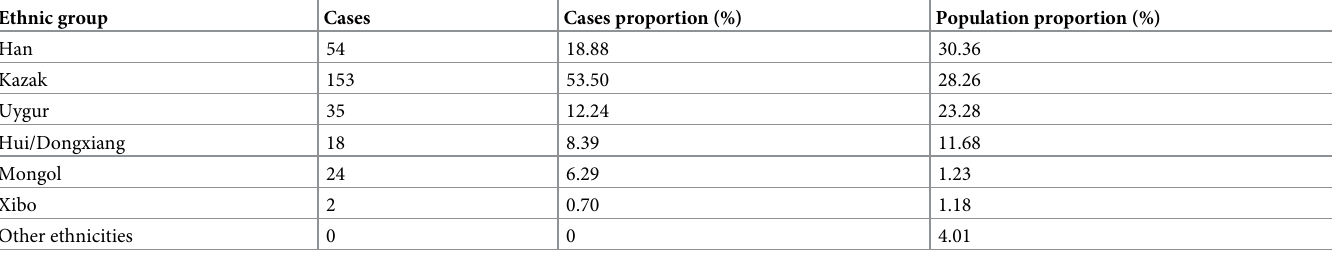
Table 2. The cumulative number of cases and the proportion of the population for the different ethnic groups in 2015. Ethnic